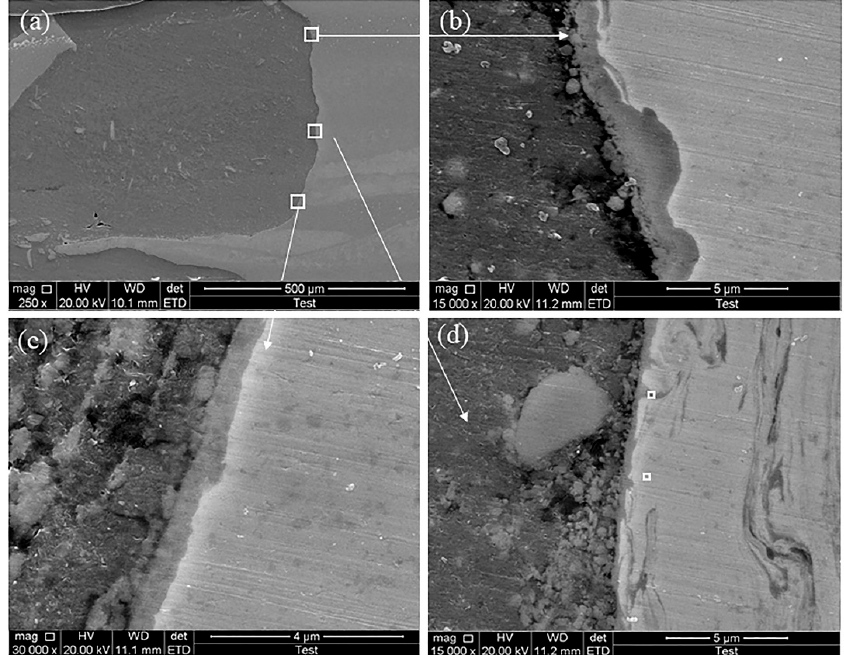
Figure 8. SEM image of ultra-HRS-FSW interface and EDS measuring position under a high tool offset. ( a ) Low magnification SEM picture, ( b ) SEM Al-Fe interface picture at the top, ( c ) SEM Al-Fe interface picture in the middle, ( d ) SEM Al-Fe interface picture at the bottom and EDS point scan position.